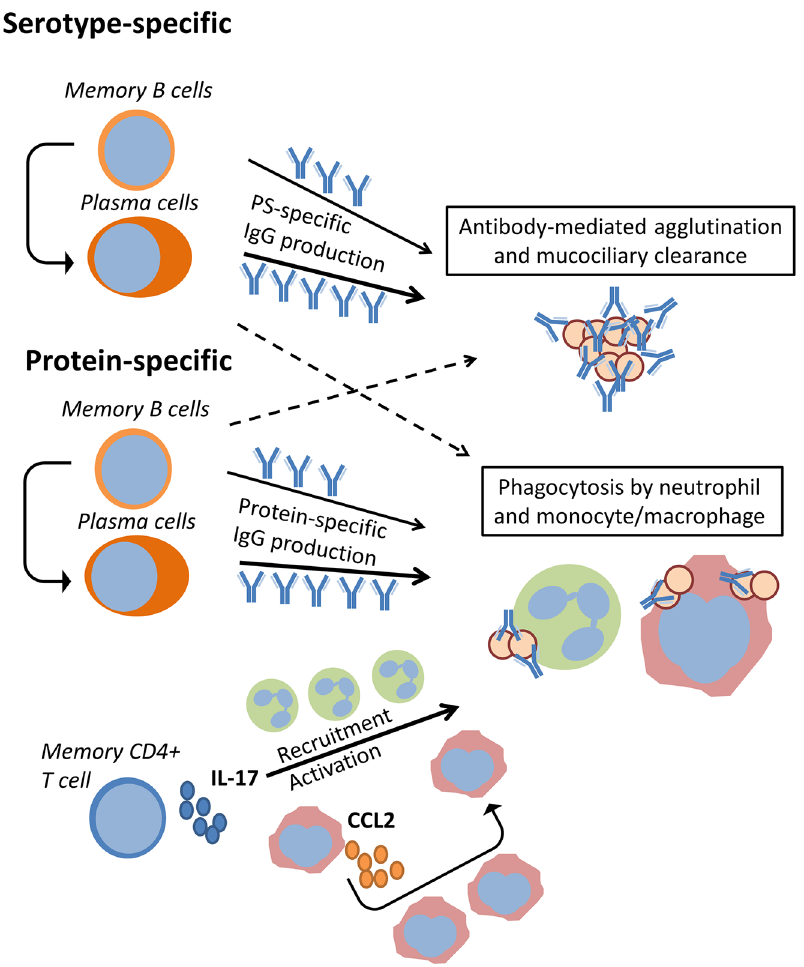
Fig 1. Immunological mechanisms of control of pneumococcal carriage. The serotype-dependent and -independent immunologicalmechanisms that control pneumococcal carriage are depicted.Memory B cells and plasma cells specific to capsuleand proteins produceIgG. This can lead to antibody-mediated pneumococcal agglutinationand antibody-mediatedphagocytosisby neutrophils,monocytes, and macrophages. Moreover, IL-17A produced by memory CD4 + T cells might lead to recruitment and activation of neutrophils and monocytes/macrophages, thus increasing phagocytosis.CCL2, C-C motif chemokine ligand2; CD4 + , cluster of differentiation4; IgG, immunoglobulin G; IL-17A, interleukin